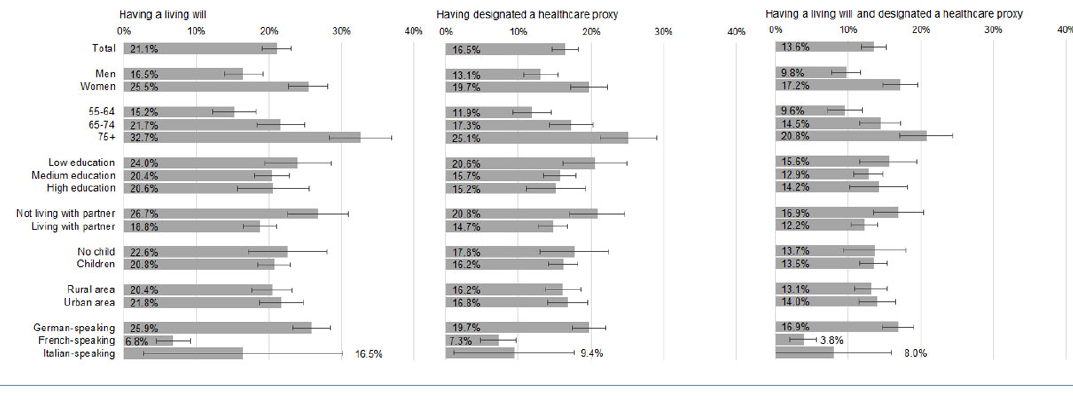
Figure 1: Completion of advance directives (ADs) by sociodemographic characteristics, adults aged 55+ in Switzerland, weighted percentage and 95% confidence intervals, SHARE 2015.